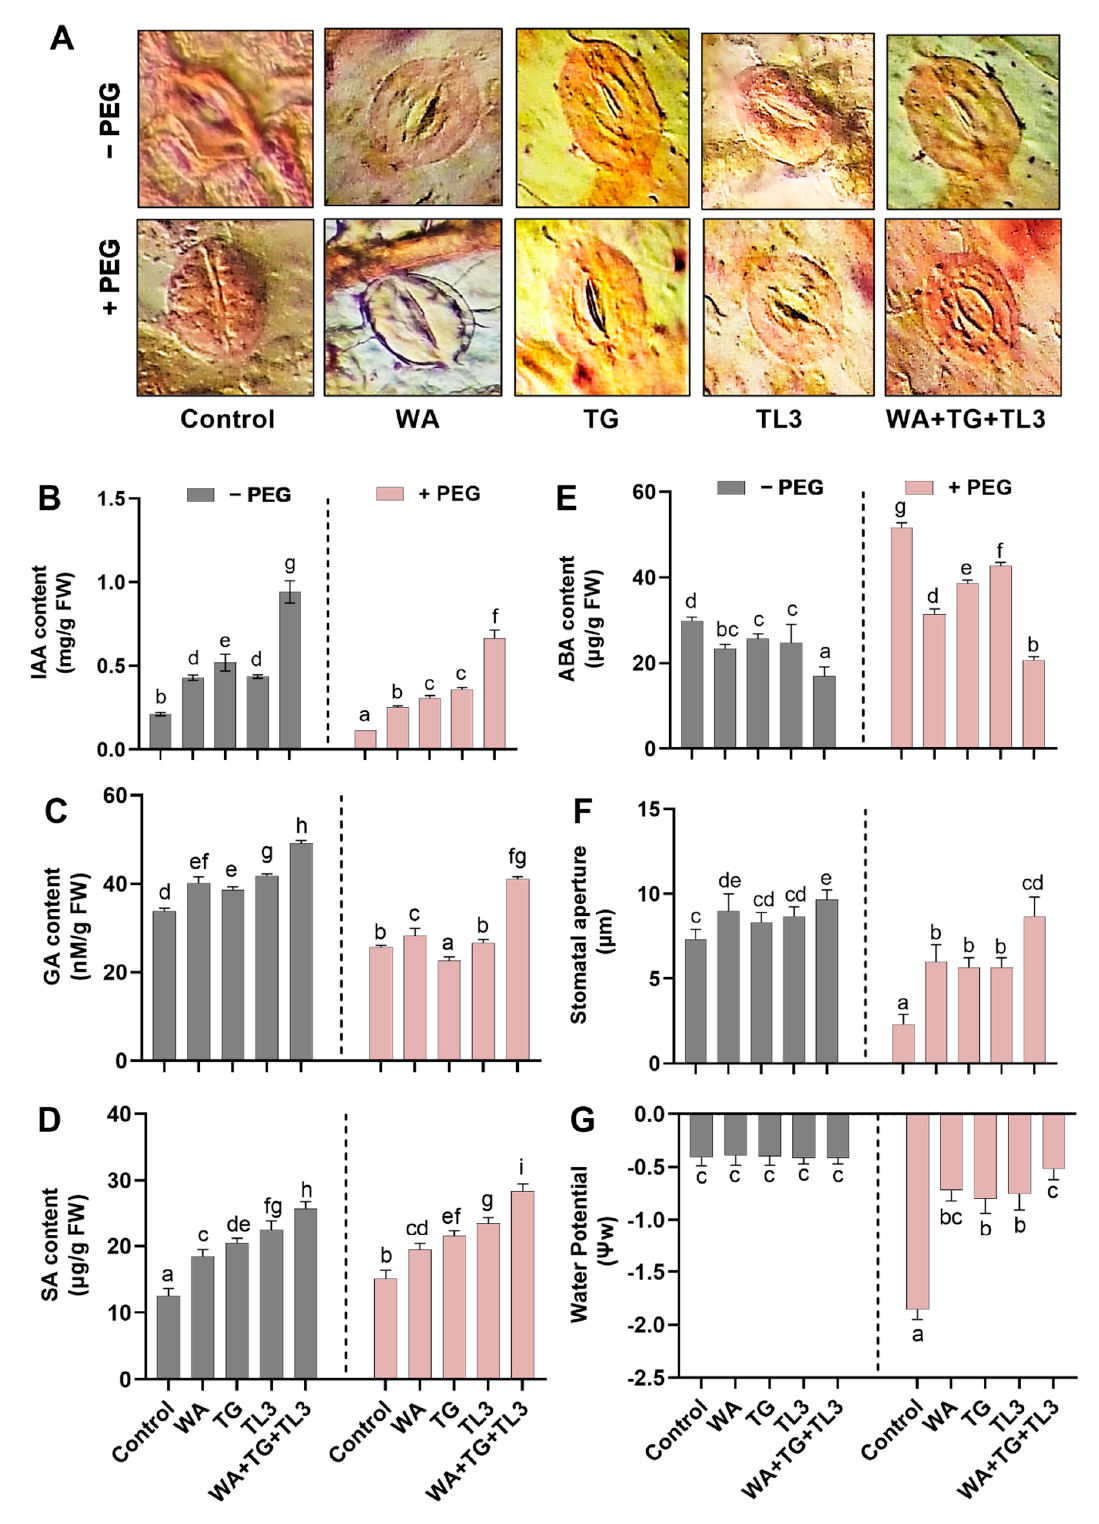
Figure 7. Effect of WA, TG, and TL3 inoculation on M. oleifera phytohormonal contents. ( A ) Stomatal anatomy, ( B ) IAA, ( C ) GA, ( D ) SA, ( E ) ABA, ( F ) stomatal aperture, and ( G ) water potential. Quantitative data represent means ± SE of three independent biological replicates presented with various letters showing differences at a significance level of p ≤ 0.05 using Duncan’s multiple range test (DMRT).